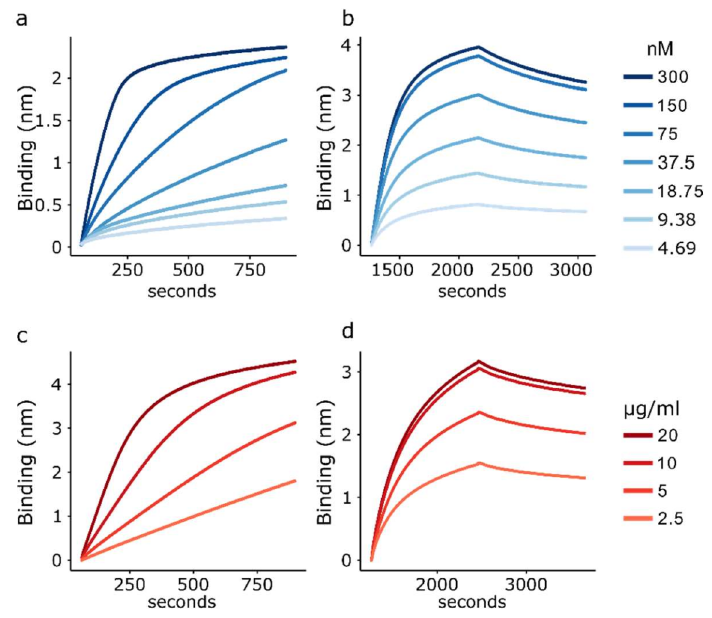
Figure 3. Biosensor loading with FMDV antigens. ( a ) BLI curves reflecting the loading of biotinylated peptide (ligand) onto the sensor surface. ( b ) Association and dissociation curves reflecting the interactions between Octet biosensors loaded with peptide and the D9 monoclonal antibody. Note: the 150 and 75 nM curves overlap. ( c ) Response levels observed when loading biosensors with different concentrations of recombinant capsid (2.5–20 µ g/mL). ( d ) Reactivity of O1 Manisa polyclonal sera with biosensors functionalised with the different amounts of recombinant